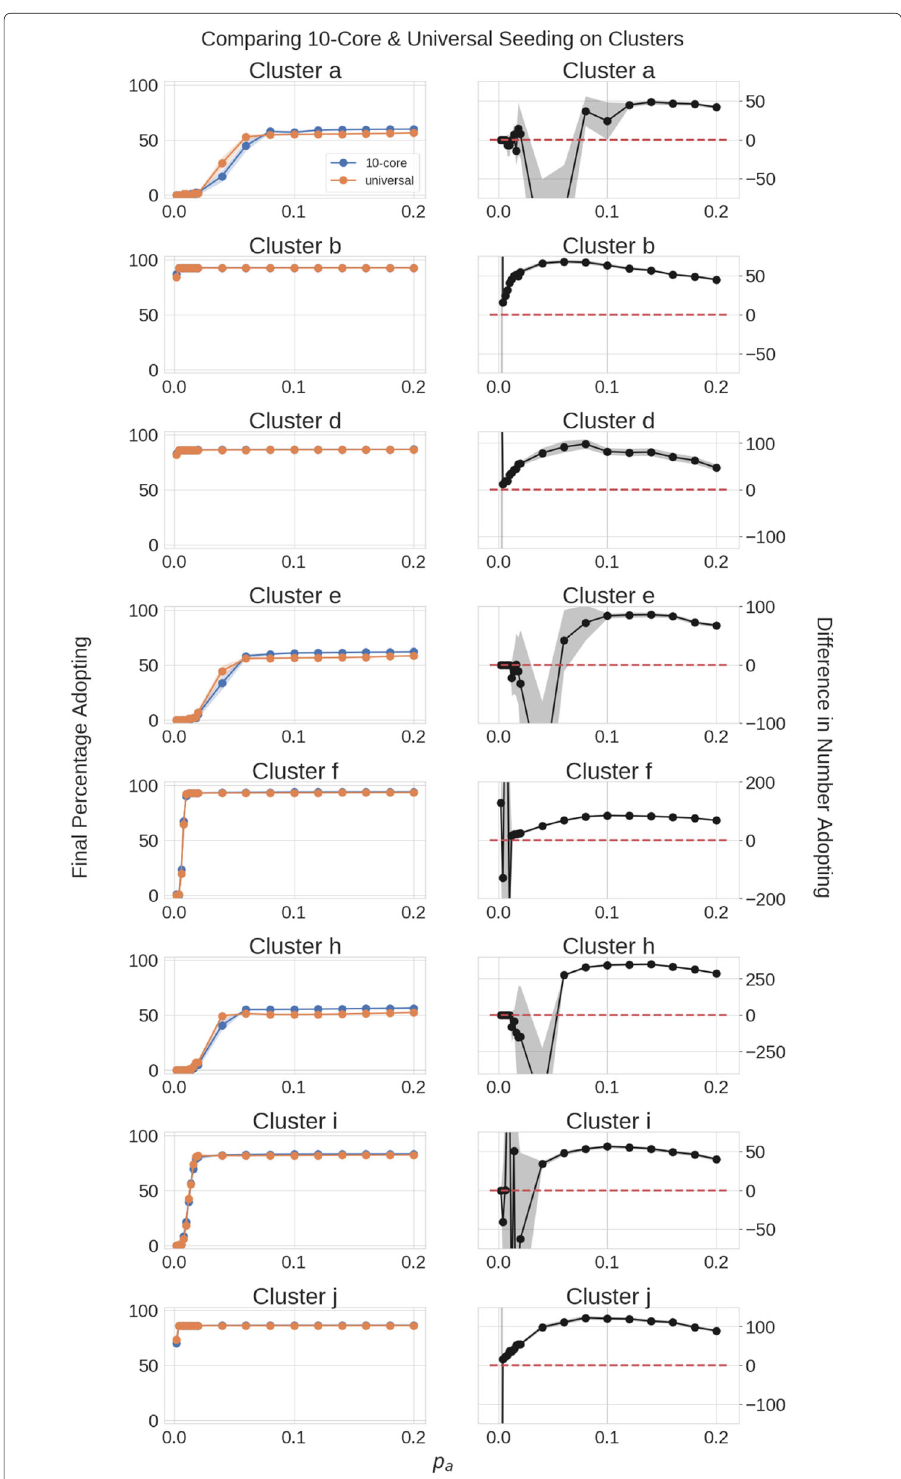
Fig. 6 Comparison of 10-core and universal seeding in the threshold model. Different rows correspond to different SH clusters from Table 1. The left-hand column shows the final percentage of the network adopting under various cluster-based seeding strategies; the right-hand column shows the difference in the number adopting under seeding the 10-core vs. the entire cluster. The parameter s i = 5 in these simulations. Each data point is an average over 100